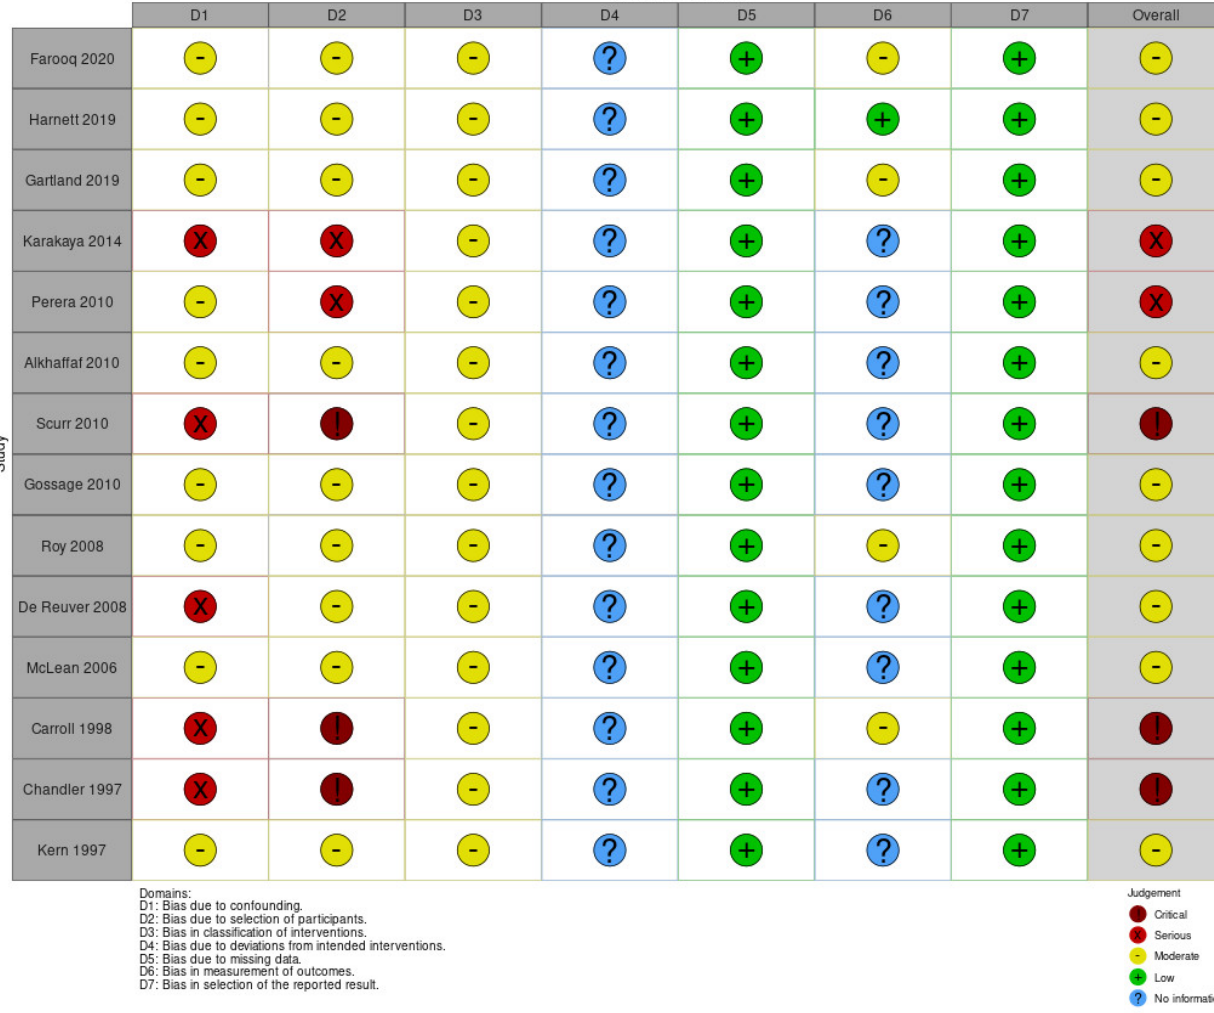
Figure 2. ROBINS-I risk of bias assessment summary: authors’ judgements about each methodological quality item for each included study.